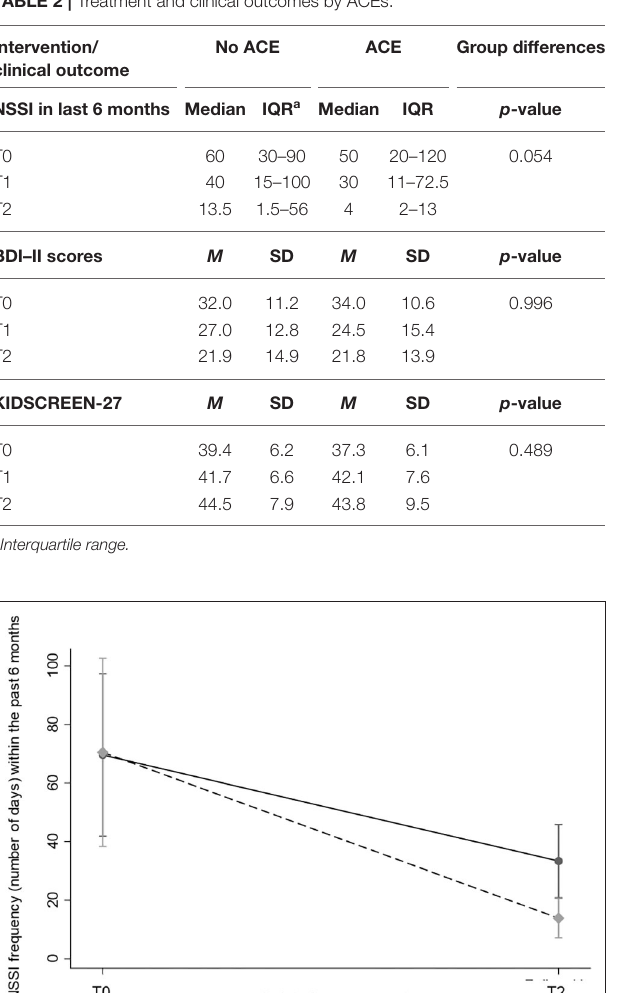
TABLE 2 | Treatment and clinical outcomes by ACEs.